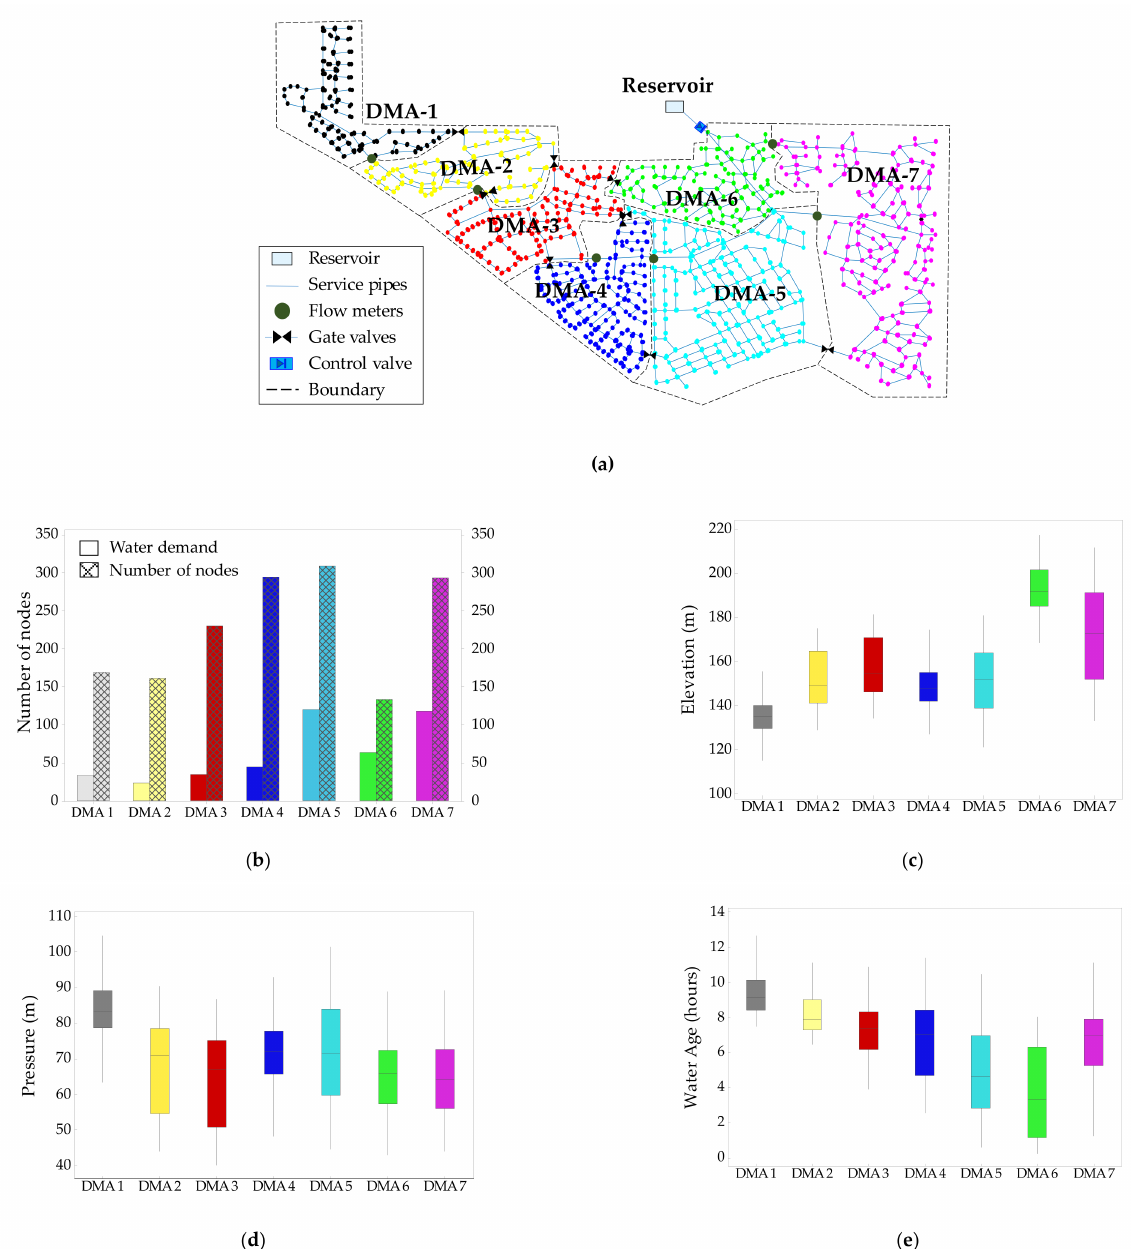
Figure 11. Performance of optimal layout with 7 DMAs operating under the normal condition: ( a ) DMA layout; ( b ) bar chart representing the size of each DMA; ( c – e ) show the variations in elevation, pressure, and WA, respectively, in each